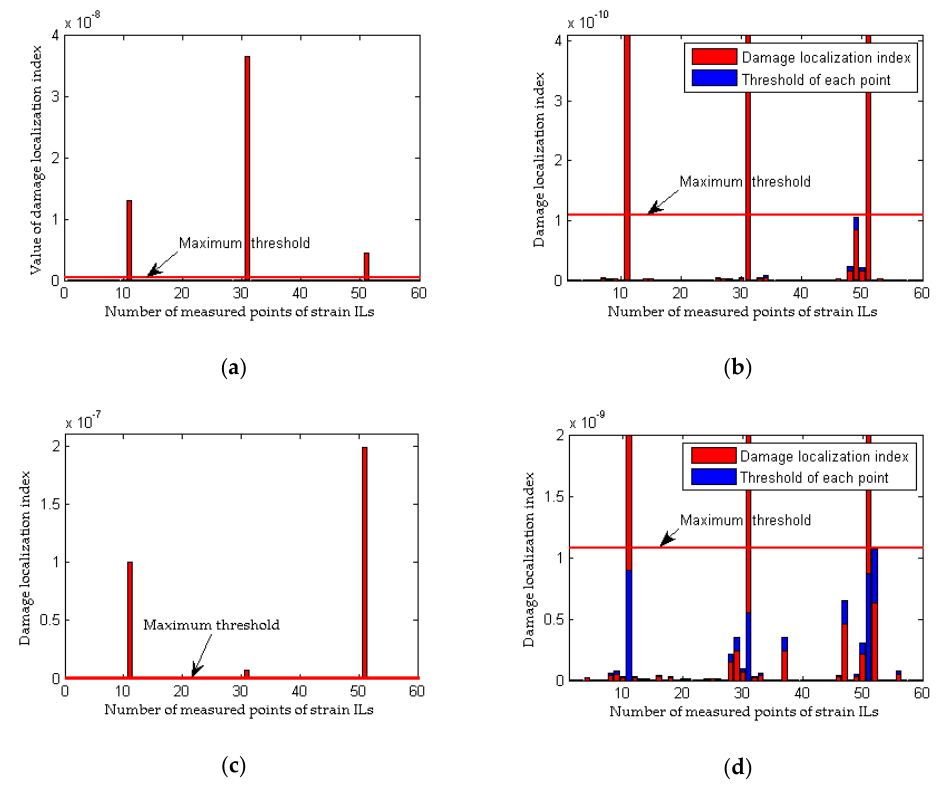
Figure 11. Results of the proposed method considering the effects of measurement noise (for multiple damaged elements): ( a ) results of the proposed method for case 6; ( b ) detailed magnification of the results of the proposed method for case 6; ( c ) results of the proposed method for case 7; ( d ) detailed magnification of the results of the proposed method for case 7.